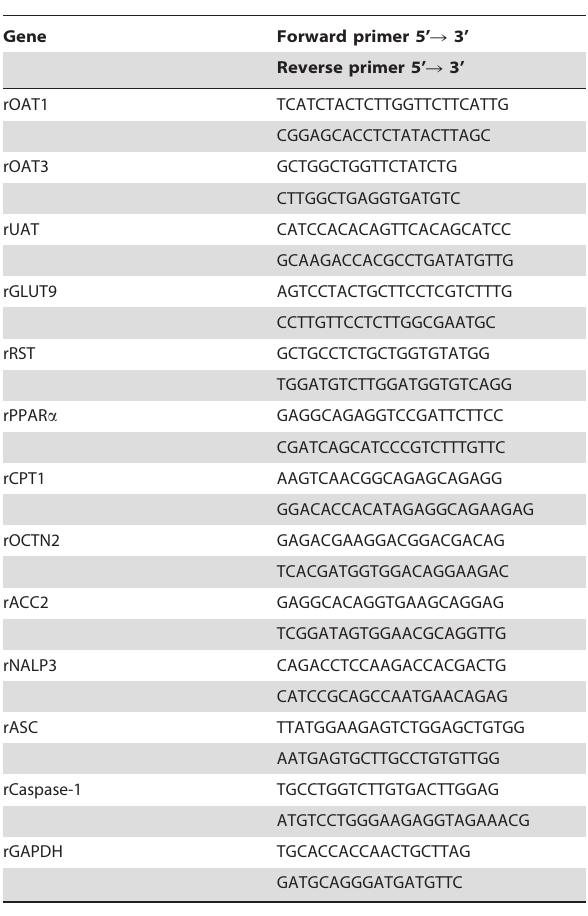
Table 1. The primers used for Real-Time PCR.